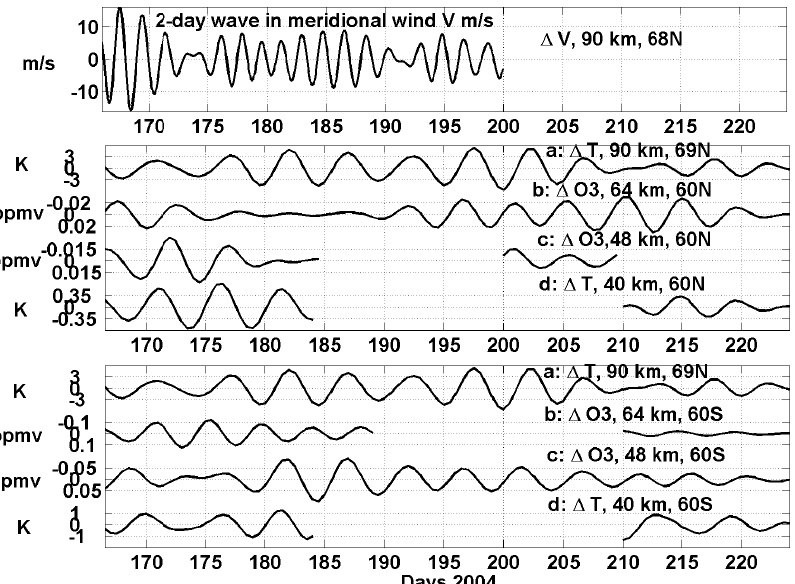
Fig. 6. Wave perturbations for 14 June–11 August 2004: Upper panel: 2-day wave from ground-based radar measurements of meridional wind (m/s) over Esrange (67 ◦ 56 0 N, 21 ◦ 04 0 E), at 90km. Middle panel: 5-day perturbations: (a) from ground-based radar measurements of temperature over Andenes (69 ◦ 17 0 N, 16 ◦ 00 0 E), at 90km. (b–d) from Odin retrievals at latitude=60 ◦ N, longitude=21 ◦ E: for ozone (ppmv) at 64km (b) and at 48km (c), for temperature (K) at 40km (d), (Note: reverse scale for ozone). Lower panel: 5-day perturbations: (a) same as on the middle panel. (b–d) same as on the middle panel but for latitude=60 ◦ S. (Note: reverse scale for